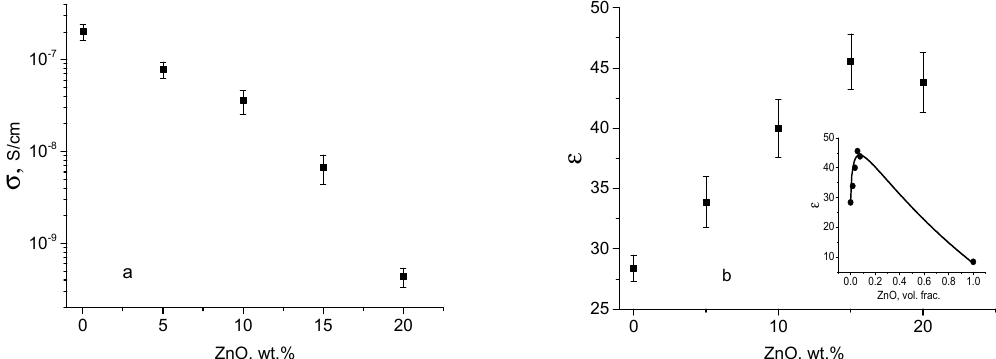
Figure 4. Dependences of ( a ) DC conductivity ( σ ) and ( b ) dielectric constant ( ε ) in the limit of zero frequency obtained in CS-ZnO films with different ZnO concentration at room temperature. Insert in Figure 4b shows dependence of ε on the volume fraction of ZnO NPs: points-experimental measurements and continuous line-results of the fitting.